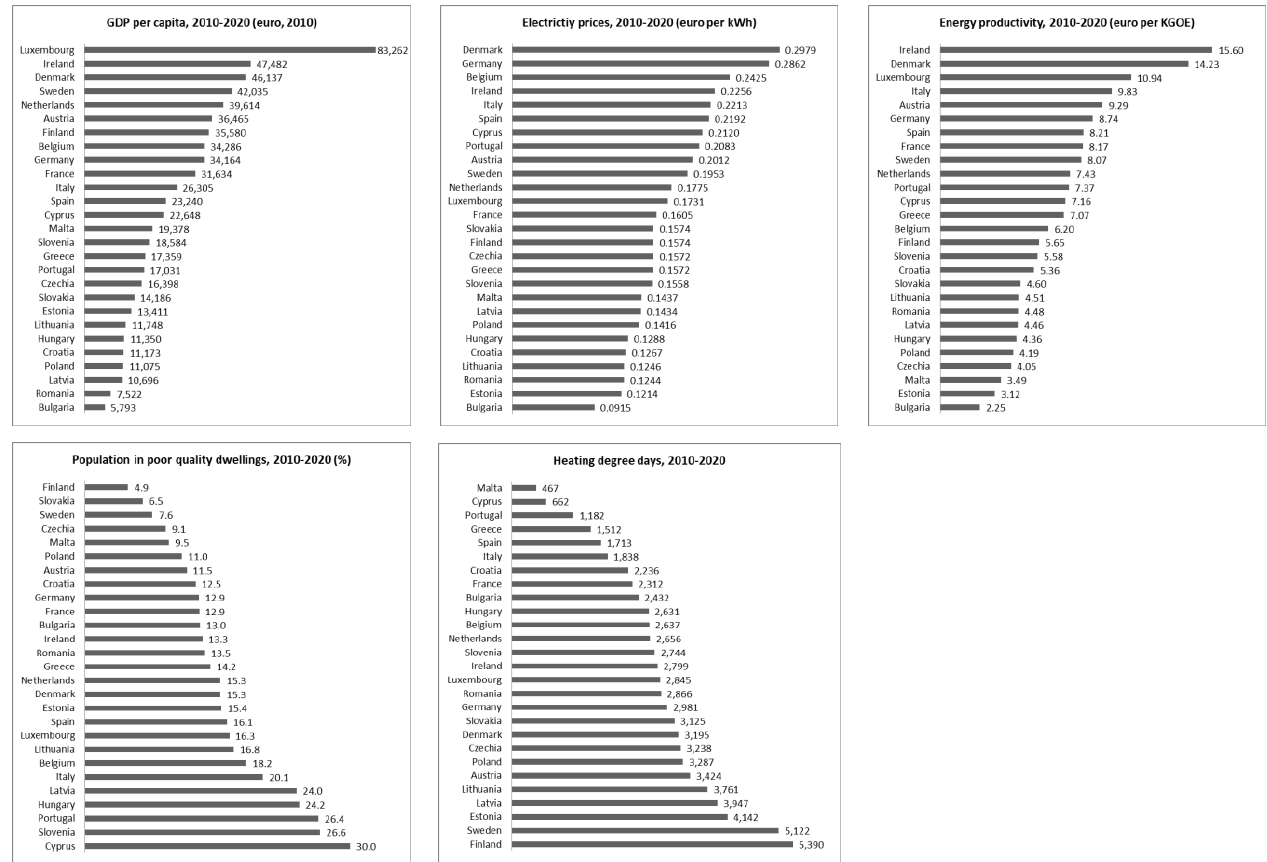
Figure 2. Main determinants of energy poverty across EU member states. Source: own research based on Eurostat data [84–88].